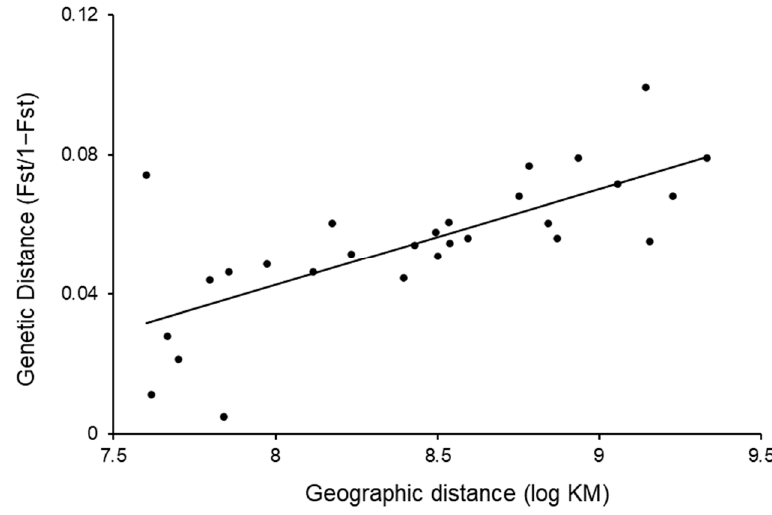
Figure 4. Relationship between genetic distances (F ST /(1 − F ST )) and logarithm of geographic distances (km) for eight locations of sugar gliders in the Berry Wildlife Corridor, Berry NSW.